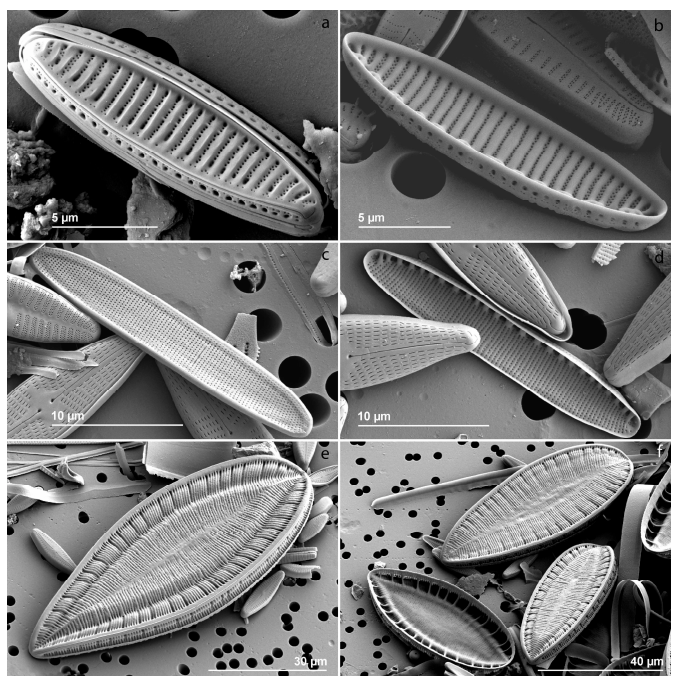
Figure 9. Scanning Electron Microscopy illustrations of some individuals observed in the studied springs. Nitzschia valdecostata ( a , b ). Nitzschia communis ( c , d ). Surirella patella ( e , f ). The eigenvalues of the first CCA axis (0.257) and the second CCA axis (0.114) were both significant ( p = 0.01 with Monte Carlo permutations test with 999 permutations), and the total explained variance in the species data was 18.5% (Figure 10). The diatom–envi- ronment correlations (Pearson) for CCA axis-1 (0.875) and CCA axis-2 (0.681) were high, indicating a relatively strong relationship between diatom species and measured environ- mental variables. Pinnularia kuetzingii , Fragilaria famelica , and Navicula veneta were associ- ated with the highest values of pH, conductivity, and TDS, and also with the highest con- centrations in lithium, potassium, chloride, and bromine ion concentrations. Crenotia an- gustior , Navicula sanctamargaritae , Sellaphora labernardierei , and Surirella patella were linked with the highest concentrations of magnesium and calcium ions, and Crenotia thermalis and Nitzschia valdecostata with the highest fluoride ion concentration. The variables with a correlation above 0.5 on the axes of the CCA were lithium, so- dium, potassium, calcium, chloride, bromine, fluoride, TDS, conductivity, and pH. Then, they were transformed in classes according to concentration (using a k-means-based dis- cretization method) used in the Kruskal–Wallis and the MRPP analyses (Table 4).